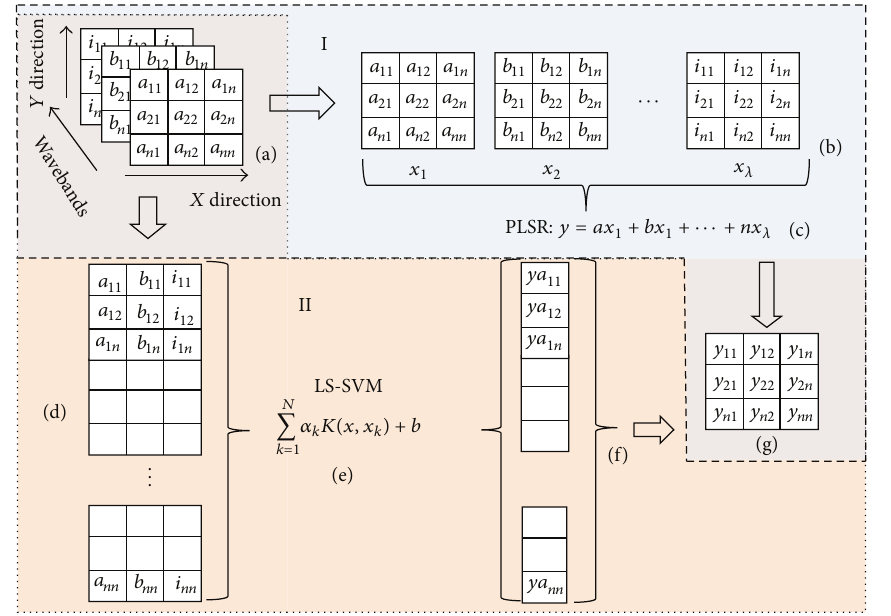
Figure 4: Visualization flowchart based on PLSR and LS-SVM.